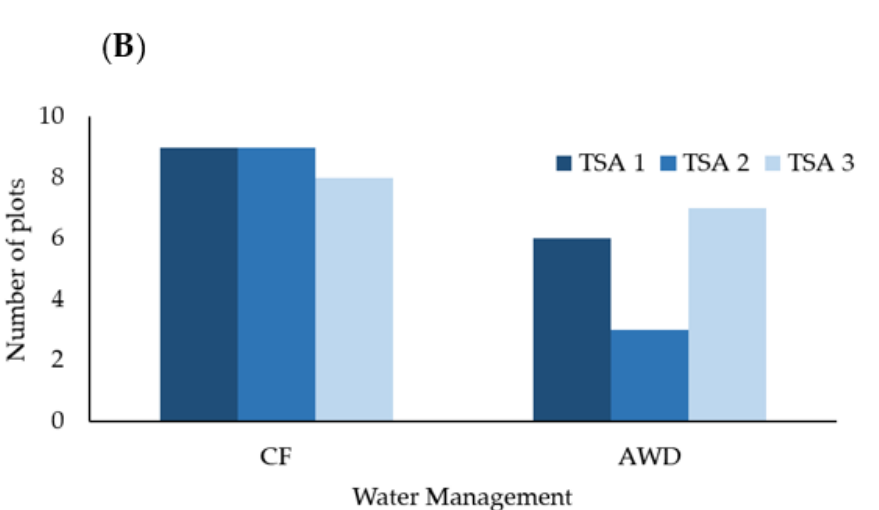
Figure 3. ( A ) Field water level of sampled field plots and ( B ) distribution of plots with different water management in a turnout service area (TSA) during 2018 dry season. CF: Continuously flooded; AWD: Alternate wetting and drying. Error bars represents the standard deviation .